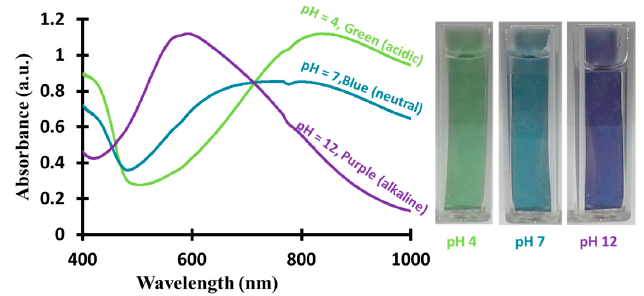
Figure 3. Digital images for optical membrane sensor immersed in solutions with different pH ( right ); and the corresponding visible-NIR absorption spectrum ( left ).